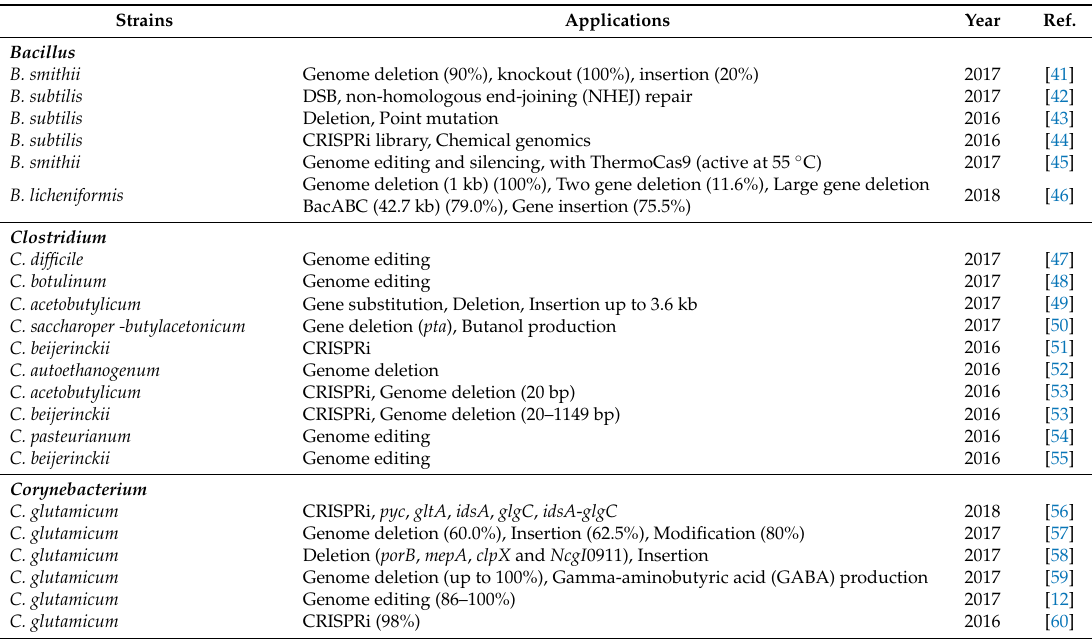
Table 1. Applications of CRISPR/Cas9 or CRISPRi systems to bacterial genome editing and silencing. Strains Applications